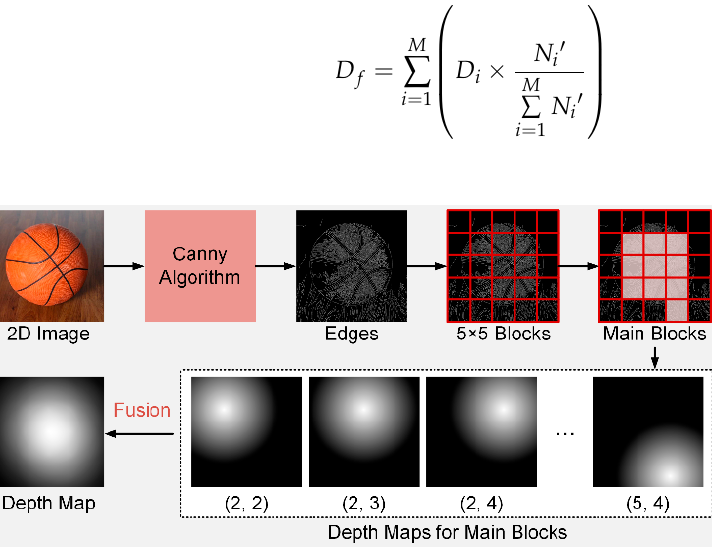
Figure 2. Calculation of the CGDM for a close-up image.